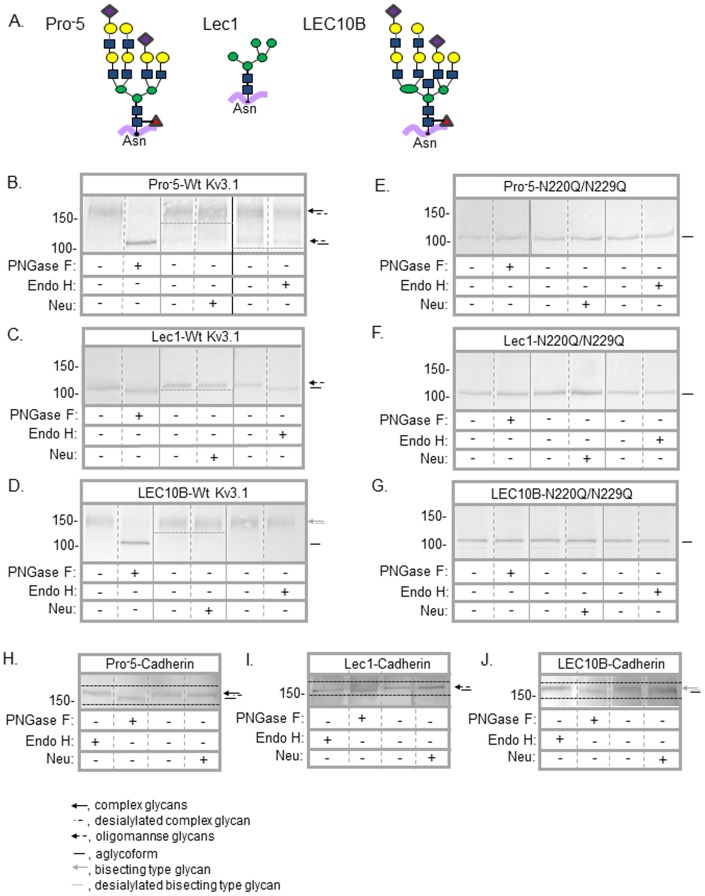
Western blots of Kv3.1 and E-cadherin glycoproteins expressed in various CHO cell lines.Diagram depicting the predominant N-linked glycans present in each CHO cell line studied (A). Symbolic nomenclature is presented as outlined by the Consortium for Functional Glycomics Nomenclature Committee as follows: ▪, N-acetylglucosamine; •green circle, mannose; •yellow circle, galactose; ♦, sialic acid; ▴, fucose. Western blots of wild type (Wt) and N220Q/N229Q Kv3.1 proteins, and E-cadherin glycoprotein digested (+) and undigested (−) with PNGase F, Endo H, and neuraminidase (neu) when heterologously expressed in Pro-5 (B,E,H), Lec1 (C,F,I), and LEC10B (D,G,J) cells, as indicated. Dashed lines below and/or above the immunobands on the various panels were employed to emphasize the small electrophoretic shifts. Solid black vertical lines denote different blot. The numbers adjacent to the Western blots represent the Kaleidoscope markers (in kDa).